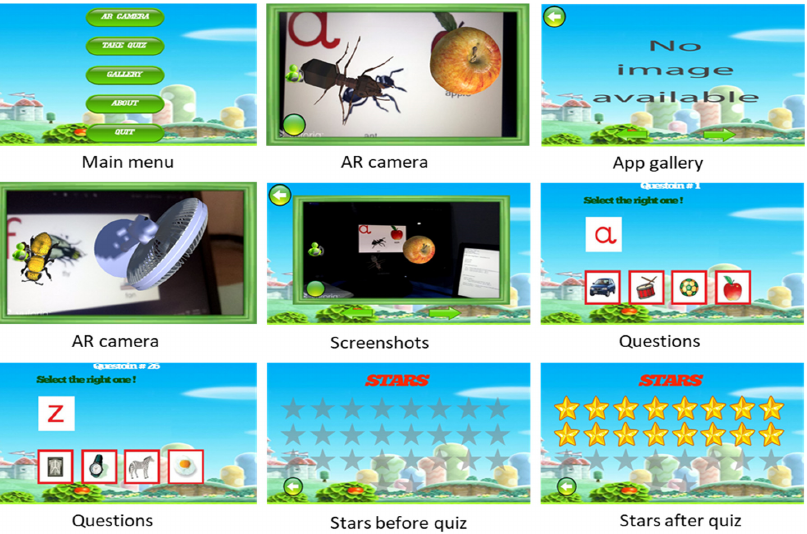
Figure 5. Screenshots of different scenes from the application “Nursery Rhyme” for learning of English alphabet.